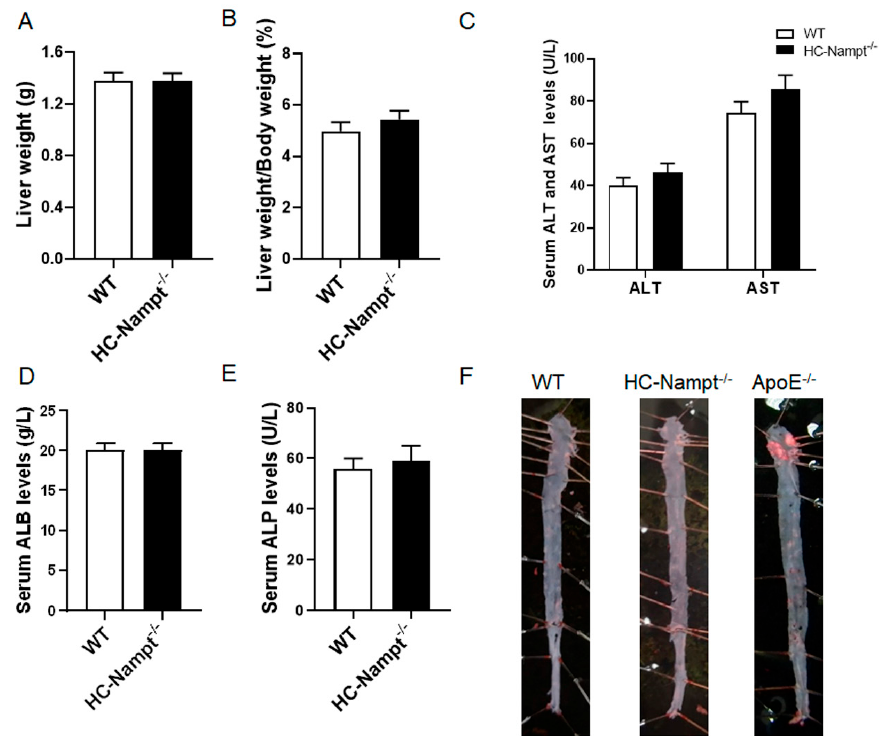
Figure 3. The effects of hepatic Nampt deficiency on liver weight, liver function, and atherosclerotic plaque formation in NCD-fed mice. ( A – B ) Liver weight ( A ) and the liver index, i.e., the ratio of the liver weight to the body weight ( B ) in HC-Nampt -/- and WT mice. ( C – E ) Serum liver functional indexes of HC-Nampt -/- and WT mice. ALT, alanine aminotransferase; AST, aspartate aminotransferase; ALB, albumin; ALP, alkaline phosphatase. ( F ) Representative images of oil red O staining on the aortas of HC-Nampt -/- and WT mice, as well as ApoE -/- mice. Data are expressed as the mean ± SEM. n = 7. No statistical significance was observed between two groups by two-tailed Student’s t - test. Weight and Fasting Blood Glucose in Mice Fed a High-Fat Diet The above results indicate that hepatic Nampt does not affect all examined physio-